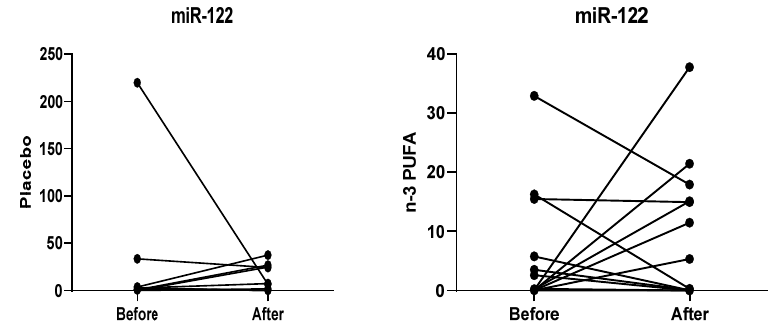
Figure 3. Comparison between the relative expression of miR-122 after six months of intervention. Within-group differences were assessed using the Wilcoxon signed-rank test.